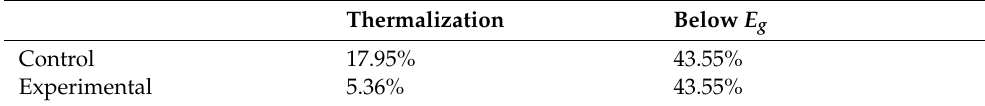
Table 3. Thermalization and below E g loss between the control and experimental case. Figure 5. Amount of loss due to thermalization loss and loss due to below-bandgap photons in the perovskite layer between the control case and the experimental case.